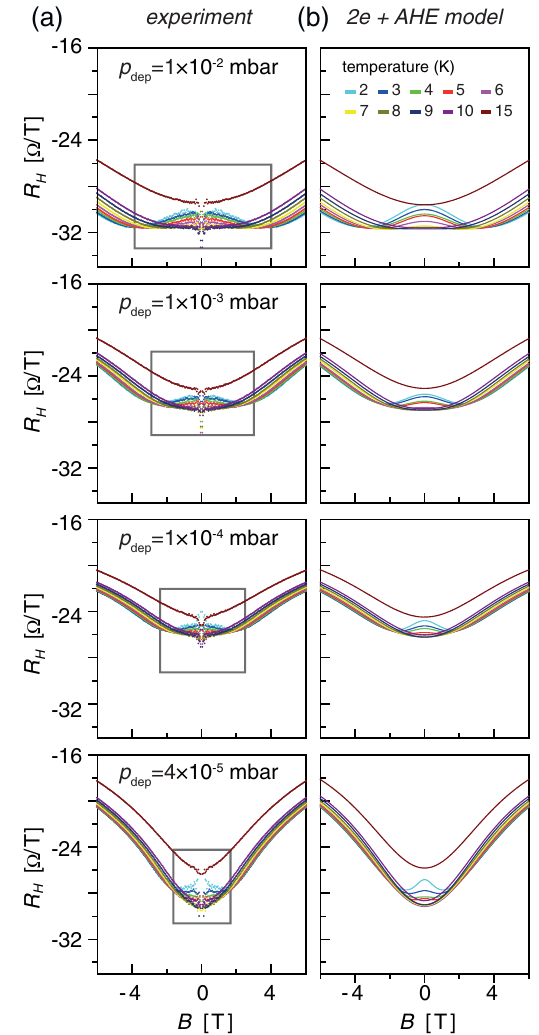
FIG. 5. (a) Antisymmetrized Hall coefficient obtained exper- imentally for various temperatures between 2 and 15 K. Gray boxes are guides to the eye approximately indicating the field range of the AHE. (b) Corresponding data fits using the extended model considering two electron populations and an AHE